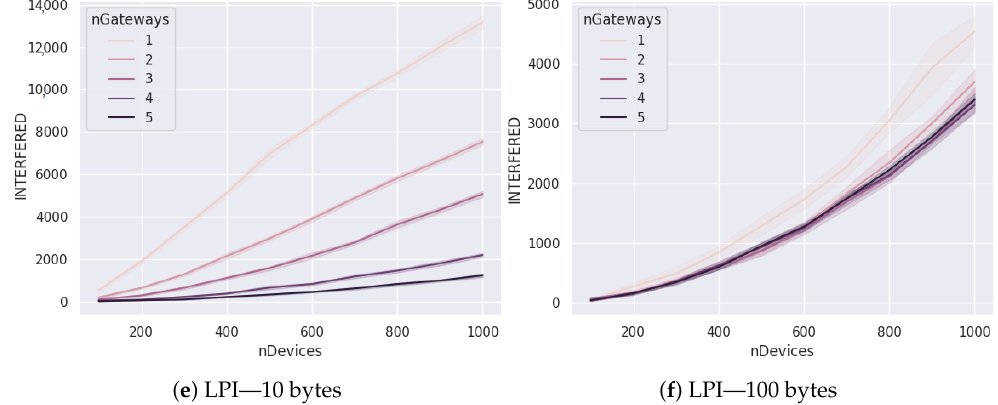
Figure 6. Performance results for a payload of 10 and 100 bytes while varying the number of gateways with a frequency of 1 packet/min—unconfirmed traffic.